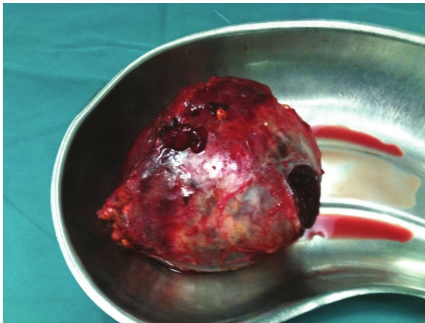
Figure 5: Right adrenalectomy.